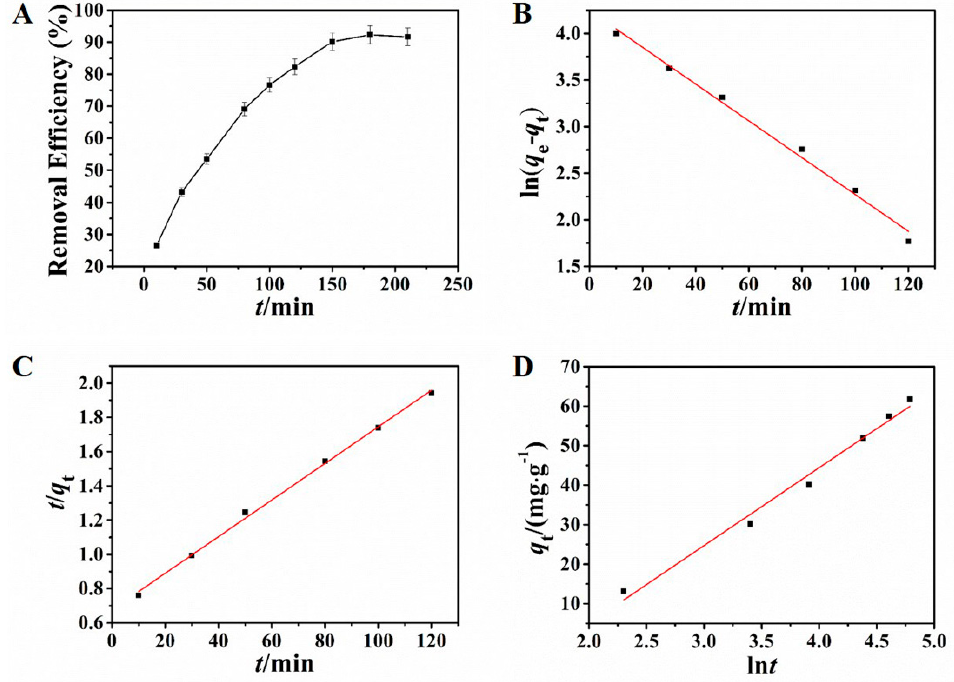
Figure 4. Influence of adsorption time toward the removal efficiency ( A ); pseudo-first-order kinetic model ( B ), pseudo-second-order kinetic model ( C ), and Elovich kinetic model ( D ) for adsorption of Pb 2+ .